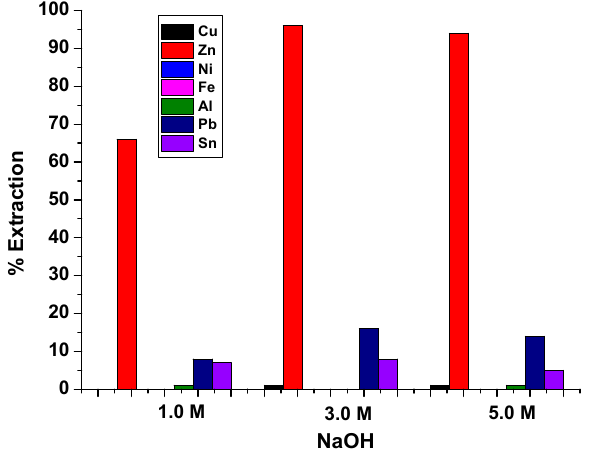
Figure 9. Comparative extraction e ffi ciencies of Cu and Zn, and the co-extraction of other metals from WPCBs using NaOH lixiviant, 50 g / L pulp density, 25 ◦ C, 300 rpm, and 12